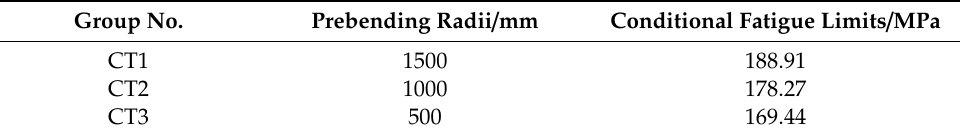
Table 3. The conditional fatigue limits of 7075 aluminum alloy at di ff erent prebending radii. Group